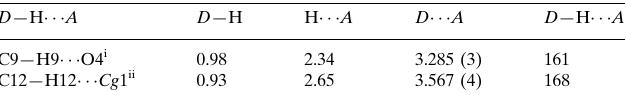
Hydrogen-bond geometry (A˚ , (cid:1)